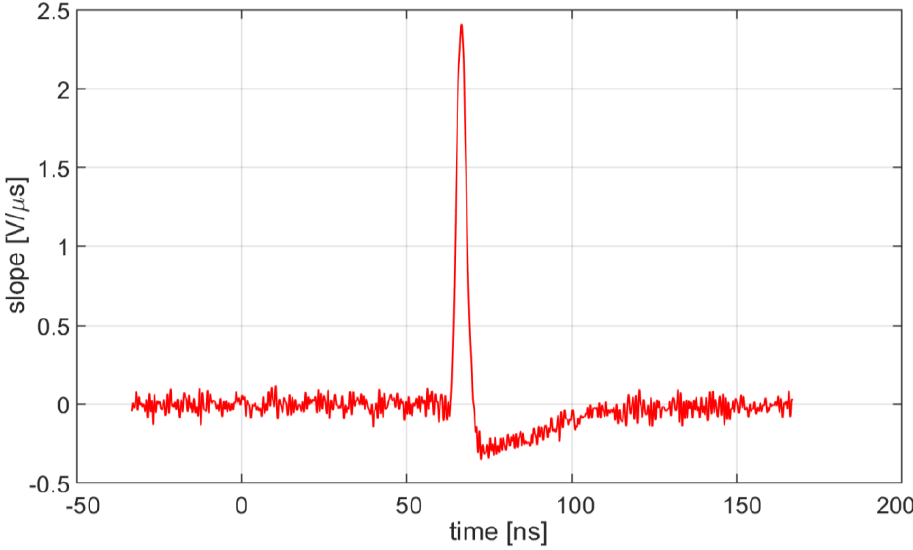
Figure 15. An example of time derivative of a ‘golden’ pulse, obtained with L = 51 nH and Rin = 33 Ω.